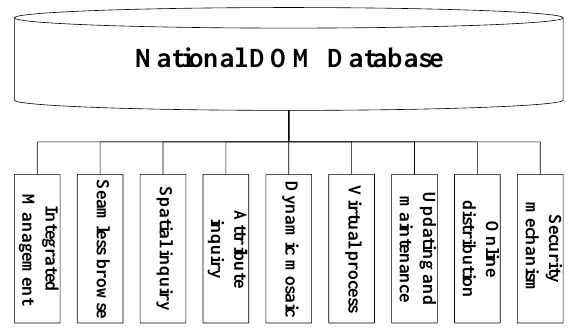
Figure 1. Function structure of national DOM